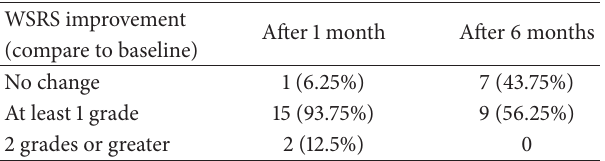
Table 2: The grades of improvement in WSRS (compared to baseline) at one month and 6 months after the beginning of the procedure.